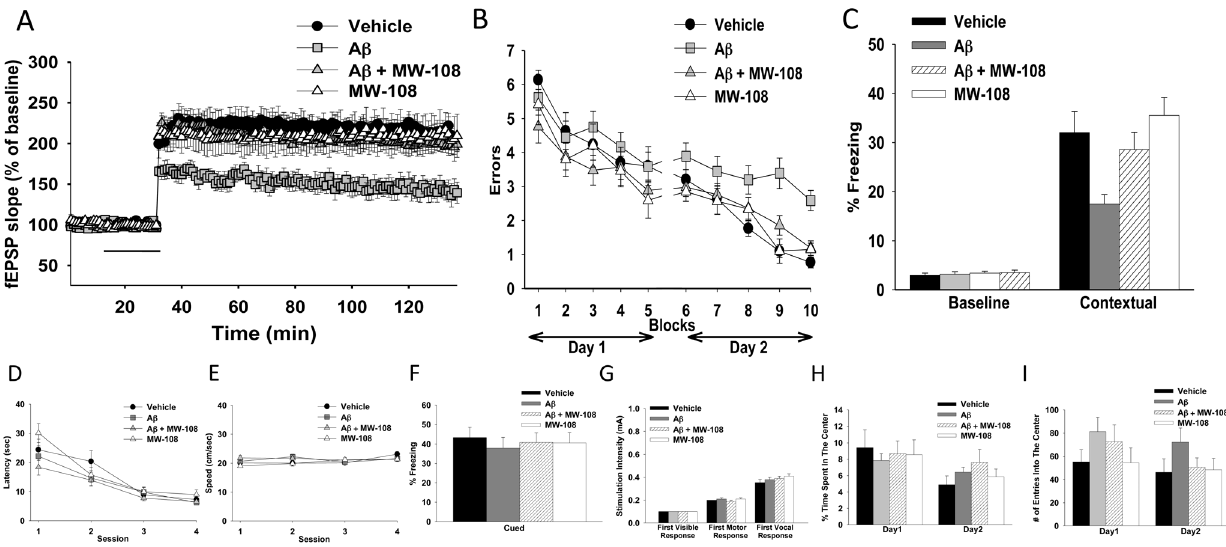
Figure 8. Attenuation of A b 42 -induced synaptic and cognitive dysfunction by MW108 administration. A. MW108 ameliorated the LTP deficit in A b 42 -treated slices (n=7–8 slices/group; F(1,13)=17.25, p=0.0011, compared to slices treated only with A b 42 ). Horizontal bar=time of application of A b 42 and MW108. B. MW108 ameliorated the reference memory deficit in A b 42 -infused mice (n=10–14 mice/group; F(1,24)=1.827, p=0.0001 comparing A b -infused vs. A b -infused + compound). C. MW108 ameliorated the contextual fear memory deficit in A b 42 -infused mice (n=16- 18 mice/group; p=0.009 comparing A b -infused vs. A b -infused + compound). D-E. No difference was detected between groups when tested for visual-motor-motivational deficits with the visible platform test; speed and time to the platform are shown in D and E, respectively (n=10–14 mice/ group). F. The same animals that underwent contextual fear conditioning testing were assessed for cued learning 24 hrs after the contextual learning. No difference was detected between groups (n=16–18 mice/group). G. Sensory threshold was not affected regardless of treatment (n=13– 17 mice/group). H-I. No differences in exploratory behavior, as shown by a similar percentage of time spent in the center compartment (H) and the number of entries into the center compartment (I), were observed (n=13–17 mice/group).